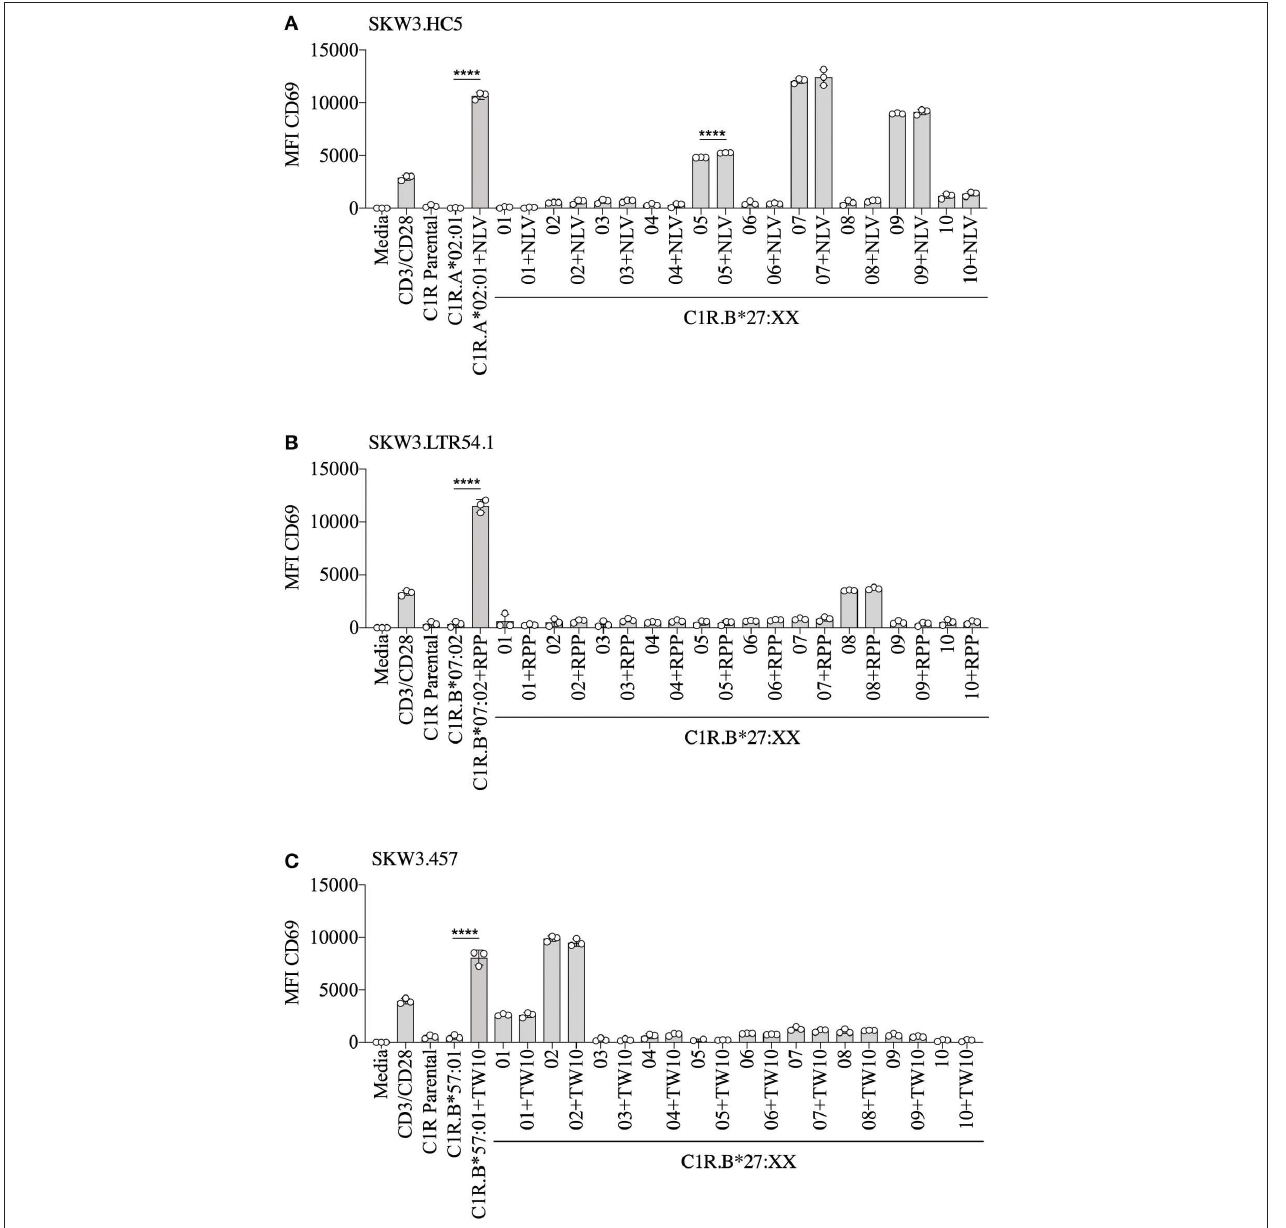
FIGURE 6 | HLA-B27 presentation of cognate viral peptide does not confer additional immunogenicity. (A) SKW.HC5 (i.e., CMV A2 NLV ), (B) SKW3.LTR54.1 (i.e., EBV B7 RPP ), and (C) SKW3.457 (i.e., HIV-1 B57 TW10 ) TCR activation was measured using cell surface CD69 upregulation after 16–20h stimulation with HLA-restricted C1R transfectants ± cognate peptide and a panel of C1R.B27 transfectants. CD69 MFI values were calculated after gating on FSC vs. SSC, single cells, GFP + cells, live cells, CD3 + CD8 + cells then CD69 + cells. Mean ± SEM are shown (single experiment with triplicate data). Statistical significance using unpaired Student’s t -test is denoted by **** p < 0.0001.